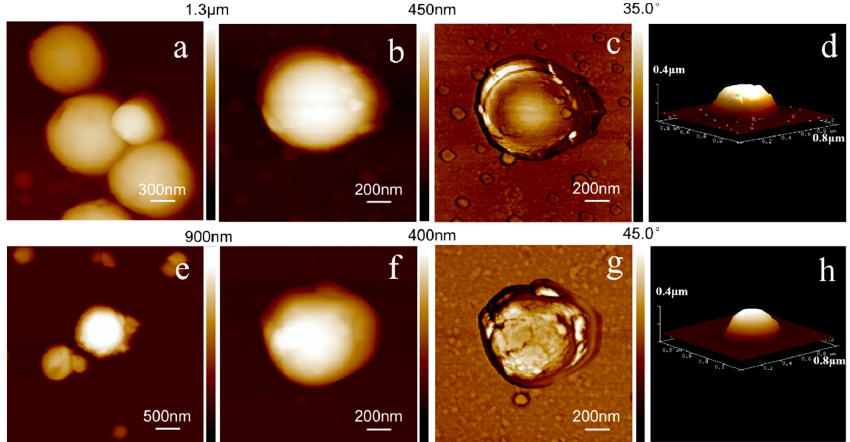
Figure 3. AFM images of the electrosprayed lignin nanospheres and Cu 2 O@L: ( a , b ) height map images of the lignin nanospheres; ( c ) phase diagram of the electrosprayed lignin nanosphere; ( d ) 3D image of the electrosprayed lignin nanosphere; ( e , f ) height map images of Cu 2 O@L; ( g ) phase diagram of Cu 2 O@L; ( h ) 3D image of Cu 2 O@L.